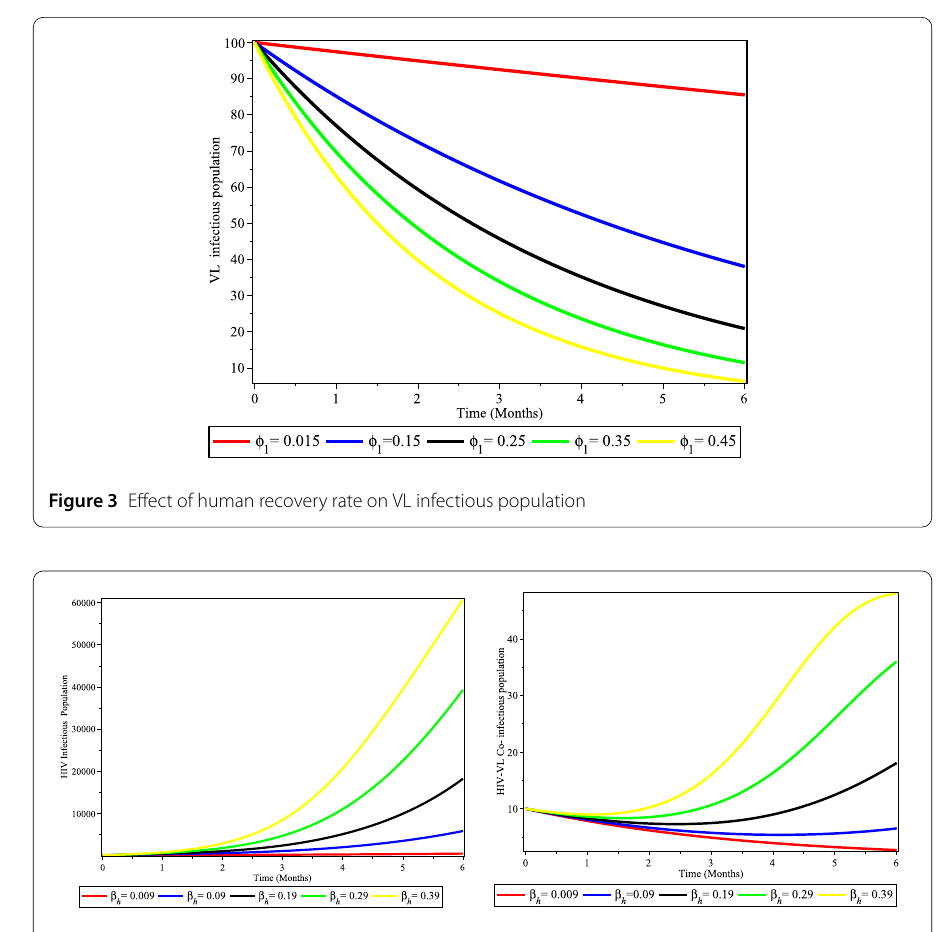
Figure 4 Effect of contact rate on HIV infectious and co-infectious